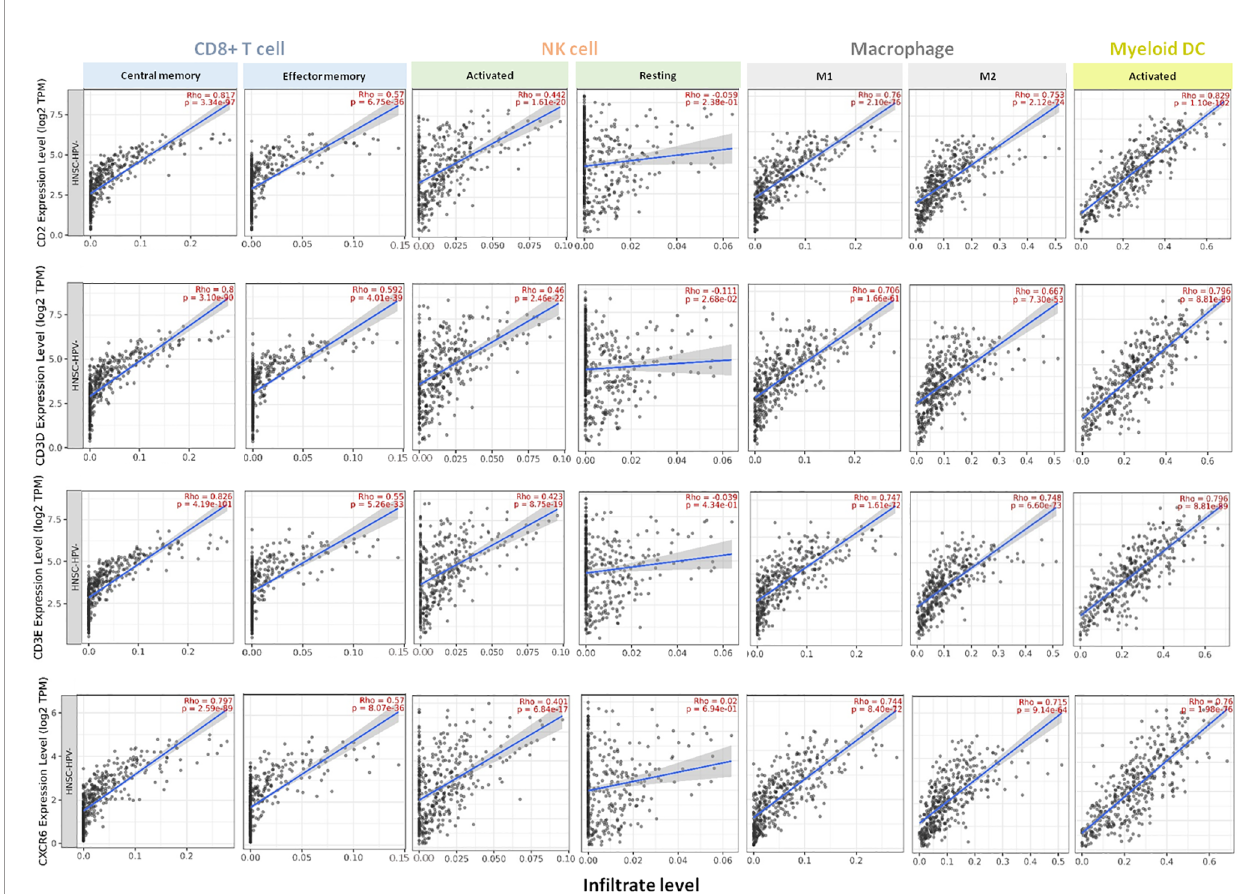
FIGURE 4 | Association of the expression of CD2 , CD3D , CD3E , CXCR6 with speci fi c tumor-in fi ltrating immune cell populations in HPV-negative HNSCC patients. Expression of each gene and association with the presence of CD8+ T cells (central memory and effector memory subsets), NK cells (activated and resting), macrophages (M1 and M2 types), and activated myeloid dendritic cells in HPV-negative HNSCC (n = 422). Each panel presents the relationship between in fi ltrates estimation value with the purity-adjusted spearman ’ s correlation parameter Rho and gene expression join p value < 0.001. Rho value > 0 represents a positive correlation, and Rho < 0 represents a negative correlation. Association with immune cell populations was provided by TIMER 2.0 software and was correlated with transcriptome expression level of each immune